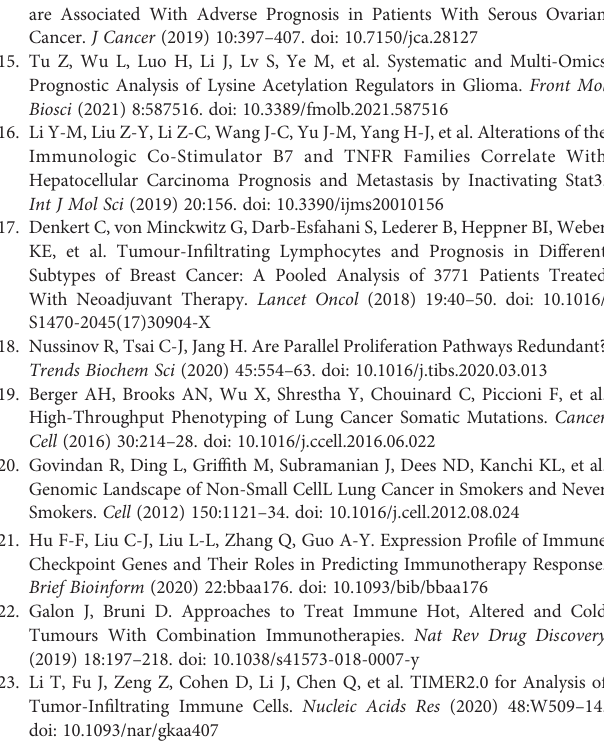
Supplementary Table 12 | Multivariate Cox Proportional-Hazards models ’ result. Supplementary Table 13 | 10-fold cross validation of nomogram